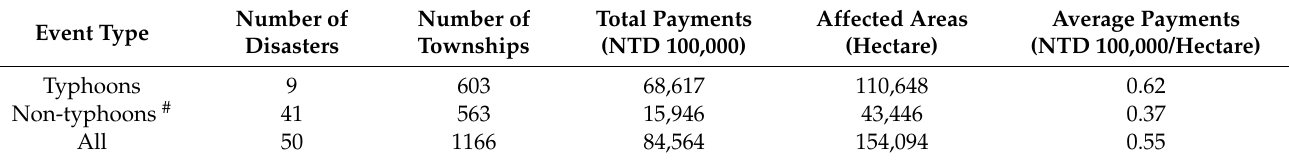
Table 1. Sample distribution of agricultural disaster payments at the township